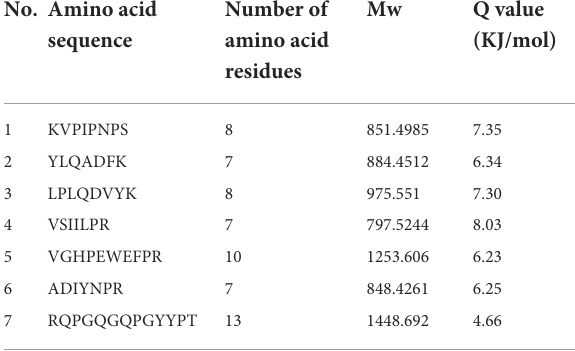
TABLE 6 Result of peptides sequence of WGH-Try4M determined by HPLC-MS/MS. No. Amino acid